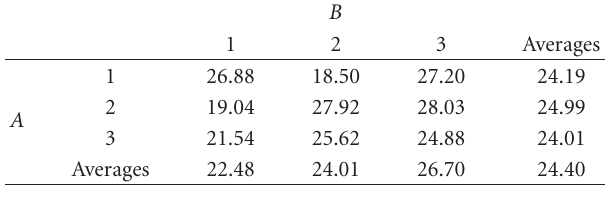
Table 9: Averages matrix for factors A and B .